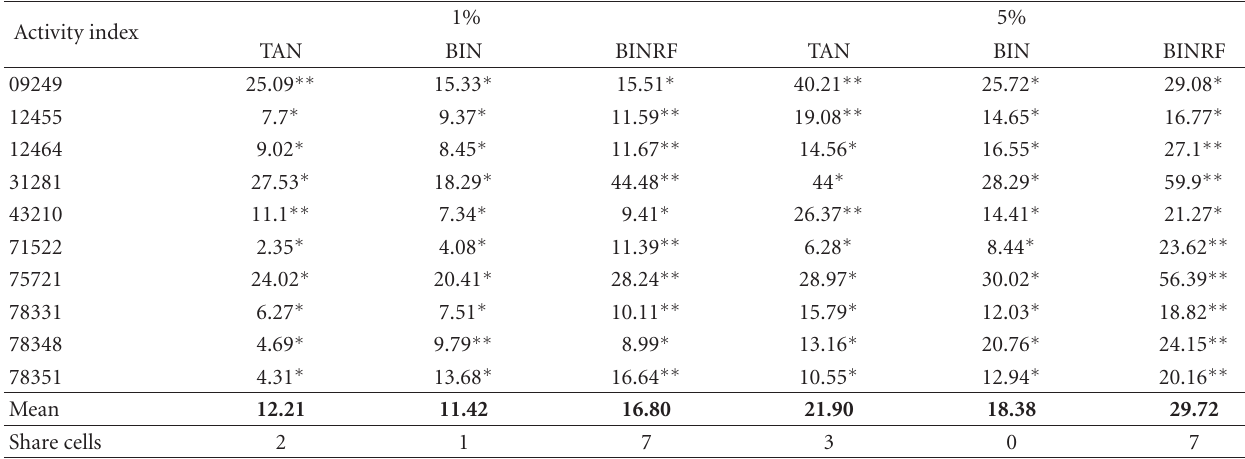
Table 6: The recall is calculated using the top 1% and top 5% of the DS3 data sets when ranked using the TAN, BIN, and BINRF. 1% Activity index